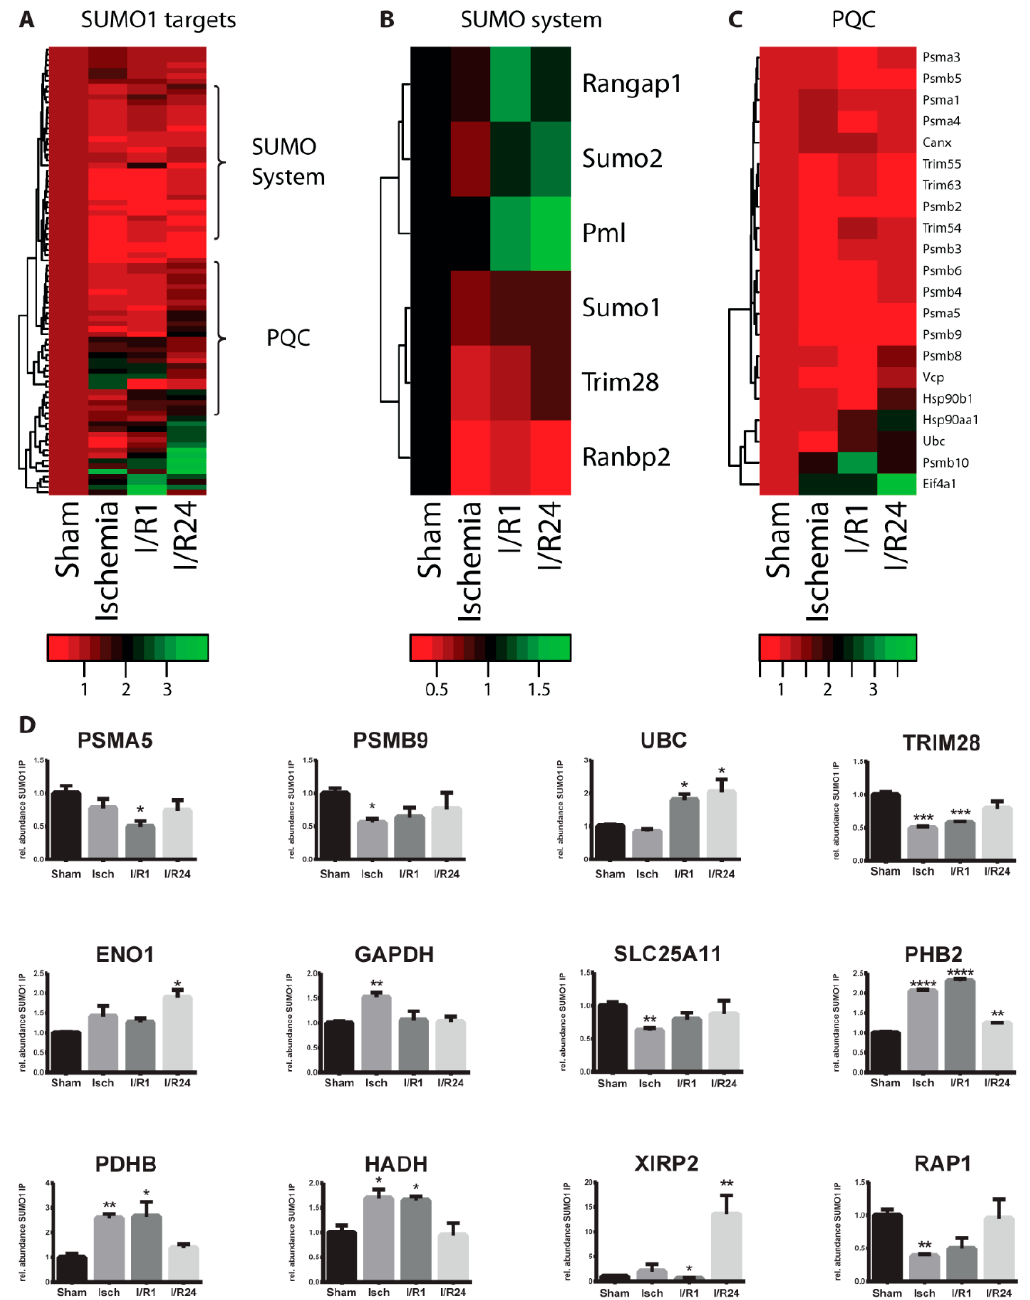
Figure 4. Cardiac I/R injury leads to dynamic changes in SUMO1 proteome. ( A ) Alteration of SUMO1 target proteins upon cardiac ischemia/reperfusion injury (I/R) in the mouse heart. Heat map displays relative changes in SUMO1 targets during I/R when compared to sham control. SUMO1 targets were defined after imputation as follows, difference SUMO IP versus IgG IP log 2 ratio >0.58 (difference is higher than 1.5 × ) and -log 10 p value > 1.3 ( p < 0.05). ( B ) Heatmap of a sub-group of SUMO1 target proteins belonging to the SUMO machinery in the mouse heart upon I / R injury. ( C ) Heatmaps of a sub-group of SUMO1 target proteins representing the protein quality control (PQC) machinery in the mouse heart upon I/R injury. ( D ) Bar diagrams of significantly changed SUMO1 targets, when experimental conditions (Isch, I/R1, I/R24) are compared to Sham. Data are expressed in mean ± SEM, asterisks show significant differences compared to Sham ( n = 3, * p < 0.05, ** p < 0.01, *** p < 0.001, **** p < 0.0001).